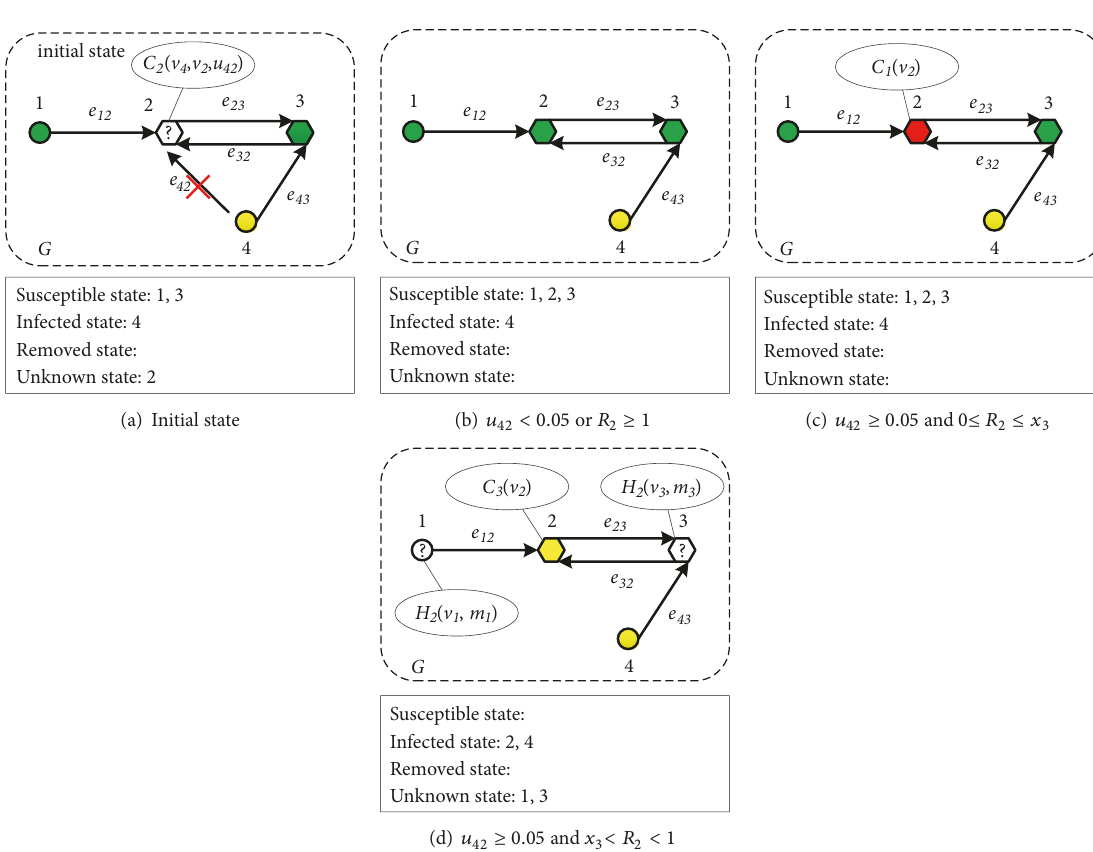
Figure 5: Influence of holder 4 on the networks when holder 4 sells the stocks issued by listed company